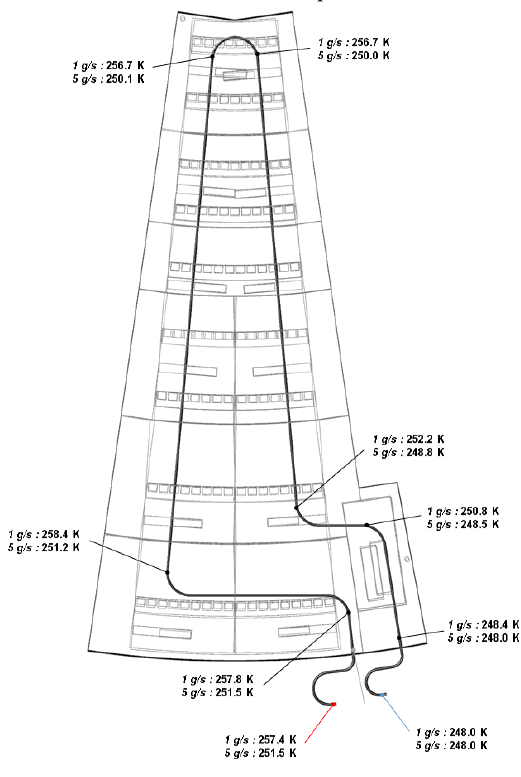
Figure 9. Temperature situation in cooling